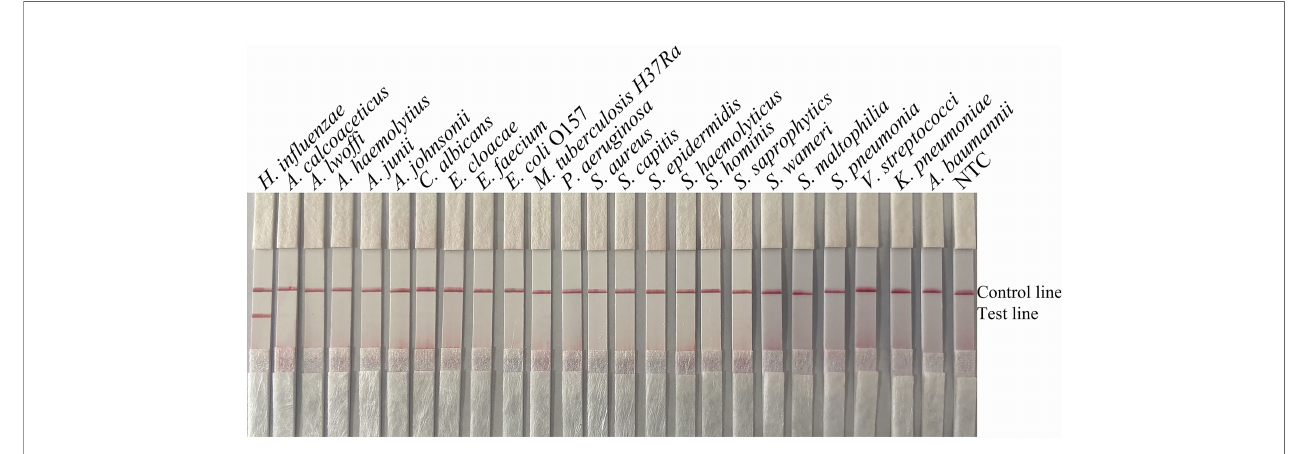
FIGURE 3 | Speci fi city of omp6 -F3/R1B/P. The template consisted of 1 µL of boiled bacterial culture at 10 6 CFU/mL. Other pathogenic bacteria were tested. H . in fl uenzae ATCC 49247 was used as a positive control. The species name is indicated at the top of each strip. NTC, no-template control. The positions of the test and control lines are marked on the right of the strip image. The reactions were performed for 30 min at 37°C. The images represent the results of three independent experiments.